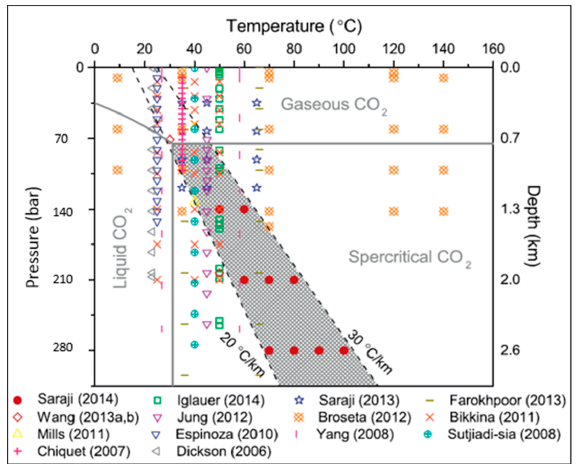
Figure 1. The pressure and temperature ranges at which saline aquifers are found underground adopted from Saraji et al. [24].